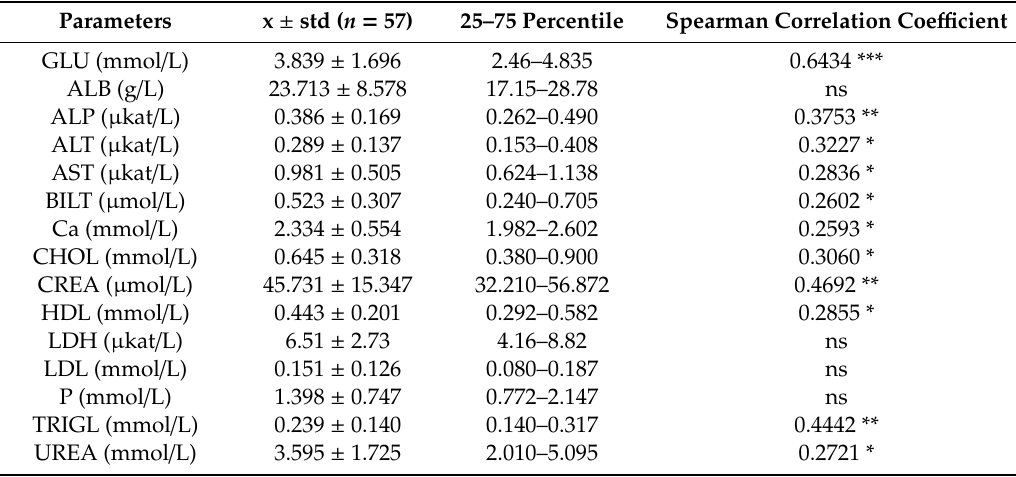
Table 1. The correlation between the ages and the activity of the selected biochemical parameters of mouflon